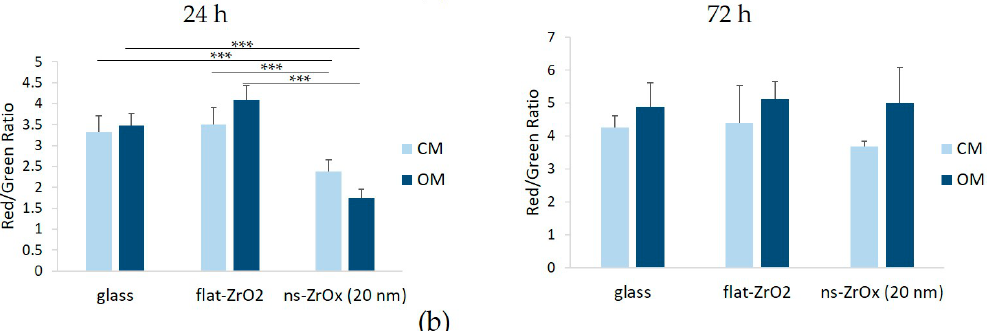
Figure 8. The effect of 20 nm ns-ZrOx on mitochondrial membrane potential. bMSCs were cultured in CM or OM on 20 nm ns-ZrOx, flat-ZrO 2 , and glass. After JC-1 staining, the cells were observed through confocal microscopy ( a ) and the red/green fluorescence ratio was measured ( b ). The decreased ratio is indicative of decreased mitochondrial membrane potential. Scale bar: 30 µ m. *** p ≤ 0.001.